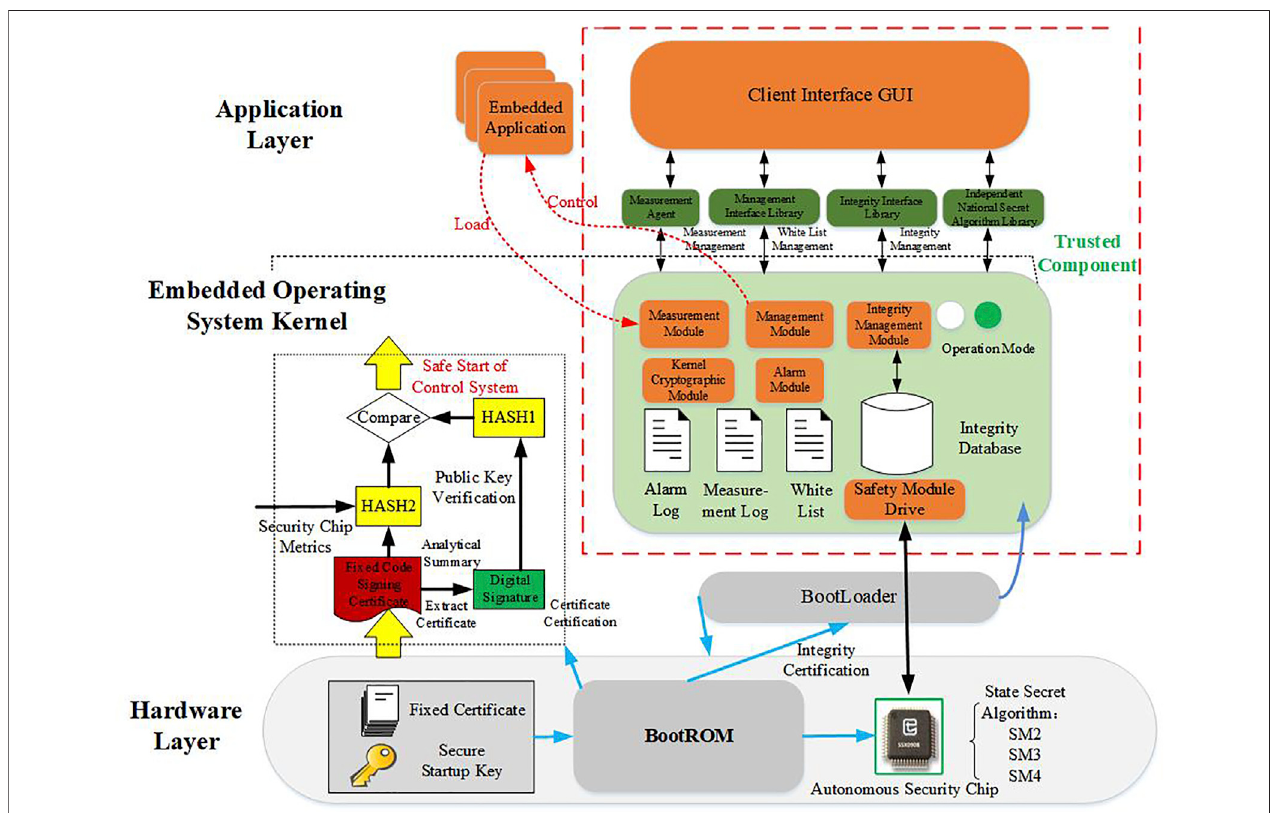
FIGURE 1 | Embedded trusted computing security protection system architecture for power industrial control terminals.